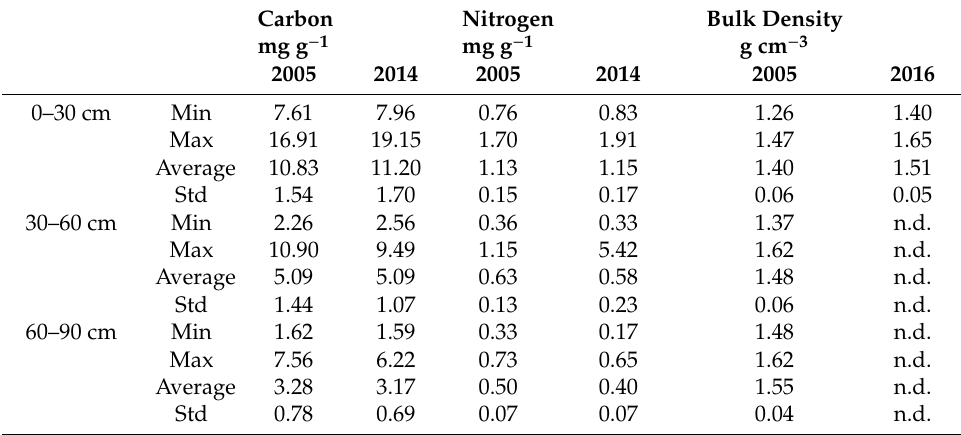
Table 2. Variability of carbon and nitrogen concentrations and bulk density for the whole site in the two sampling